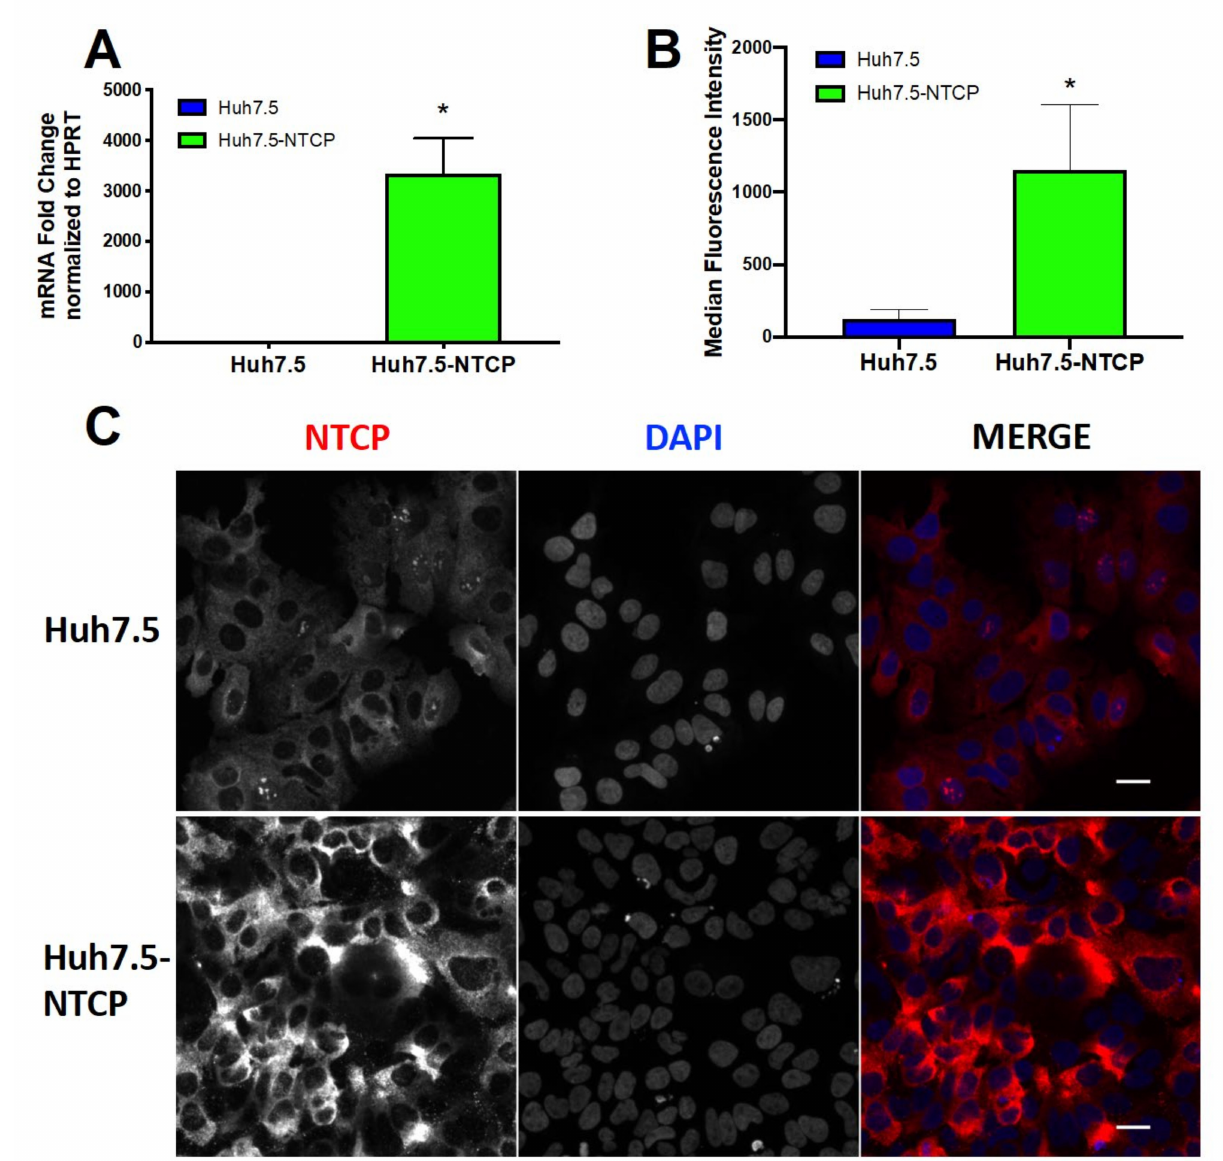
Figure 1. Overexpression of NTCP in Huh7.5 cells. ( A ) Lentiviral-transduced puromycin-selected Huh7.5-NTCP cell line expressed more NTCP mRNA than the parental Huh7.5 cell line. RT-qPCR was used to measure NTCP and hypoxanthine- guanine phosphoribosyltransferase (HPRT) mRNA levels. Huh7.5-NTCP cells expressed more cell surface NTCP than parental Huh7.5 cells as illustrated with ( B ) flow cytometry and ( C ) immunofluorescence (IF) microscopy. Immunofluo- rescent staining of NTCP is shown in red, and the DAPI (4 (cid:48) ,6-diamidino-2-phenylindole) stain of nuclei is shown in blue. Images show a single plane/z-stack. The scale bars are 10 µ m. ( A , B ) Average values with error bars ( ± SD) derived from three experiments are plotted. Unpaired Student’s t -test was used for statistical analysis. * p < 0.05; n =